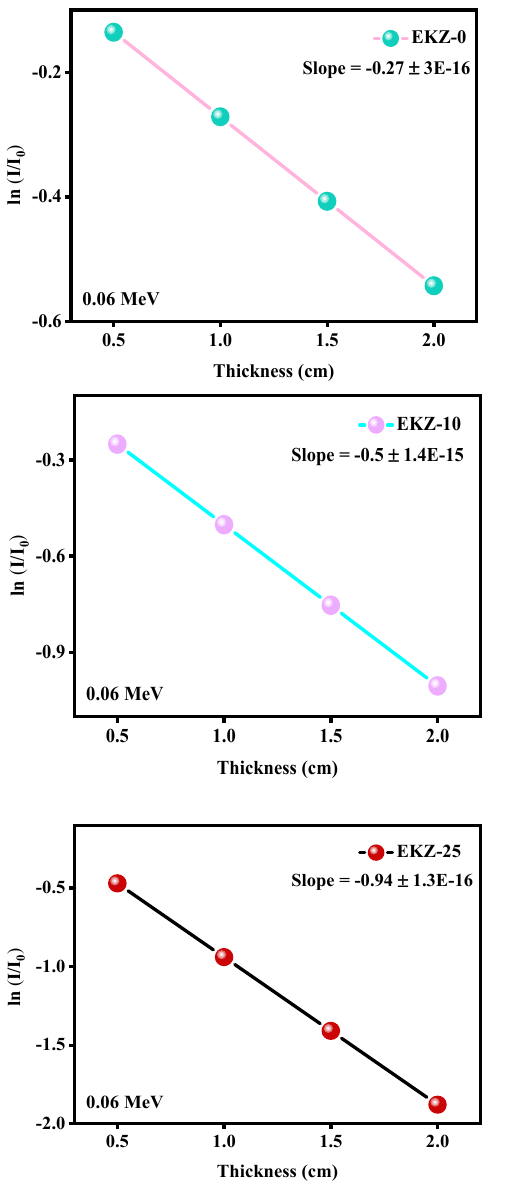
ZnO, respectively. This trend has occurred due to the increase of kaolin clay and ZnO- nanoparticles, whereas the amount of epoxy resin has decreased at the same time, resulting in a decrease in the density of the samples, which increases the LAC values as well as